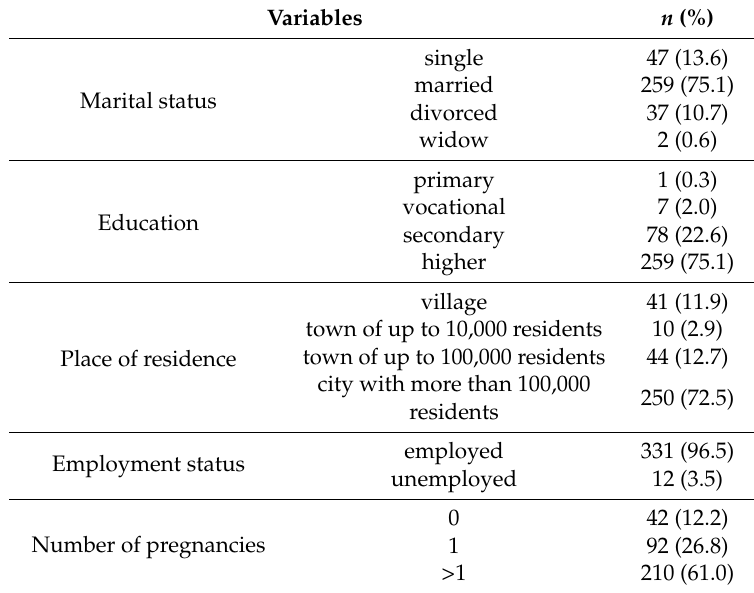
Table 2. Sociodemographic